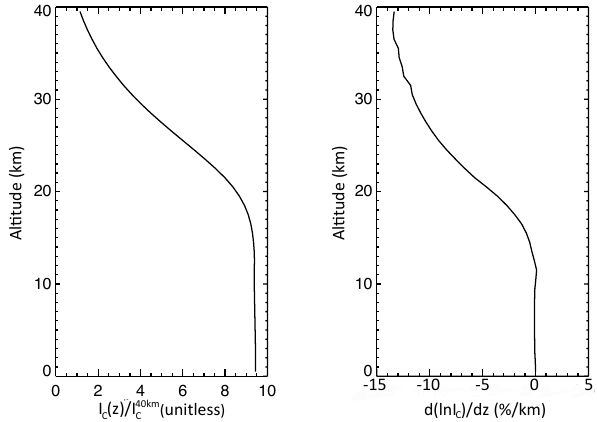
Figure 1. Left panel shows calculated 350nm radiances as a func- tion of altitude, normalized at 40.5km. The GSLS calculation mod- els the OMPS LP field of view without aerosols. The shape of the curve originates from the competition between molecular scatter- ing, which increases roughly linearly with pressure, and attenuation, which becomes important when the Rayleigh optical thicknesses near the tangent point start to become large. Attenuation causes the slope of 350nm radiances to change sharply between 40 and 20km (right panel), a ∼ 10%km − 1 difference between 20 and 40km. The slope is used to estimate altitude registration errors by comparing measured ratios with model simulated